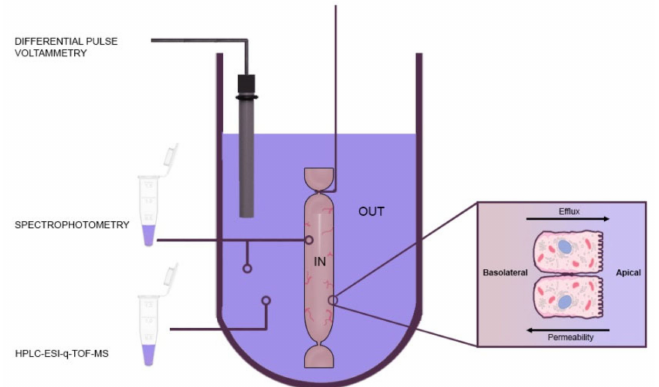
Figure 1. Real-time ex vivo monitoring of first-pass phenolic metabolism using the everted gut sac technique. The apparent permeability (P app ) and biotransformation of bioaccesible phenolic compounds (PC) and their associated first-pass metabolites were followed by spectrophotometry (Folin–Ciocalteau; 120 min), HPLC-ESI-QTOF-MS (120 min) and, di ff erential pulse voltammetry (DPV; 0 to 120 min). Di ff usion from apical (A; out) to basolateral (B; in) and B-A were considered permeability and e ffl ux,